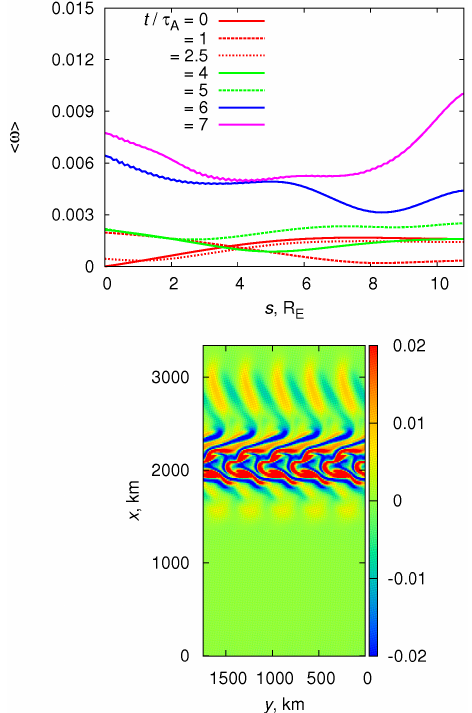
Figure 5. Upper panel: root-mean-square vorticity (cid:104) ω (cid:105) in x ⊥ (s) as a function of s and t in the case of Fig. 2. Lower panel: vorticity ω at the magnetic equator s = l at t/τ A =